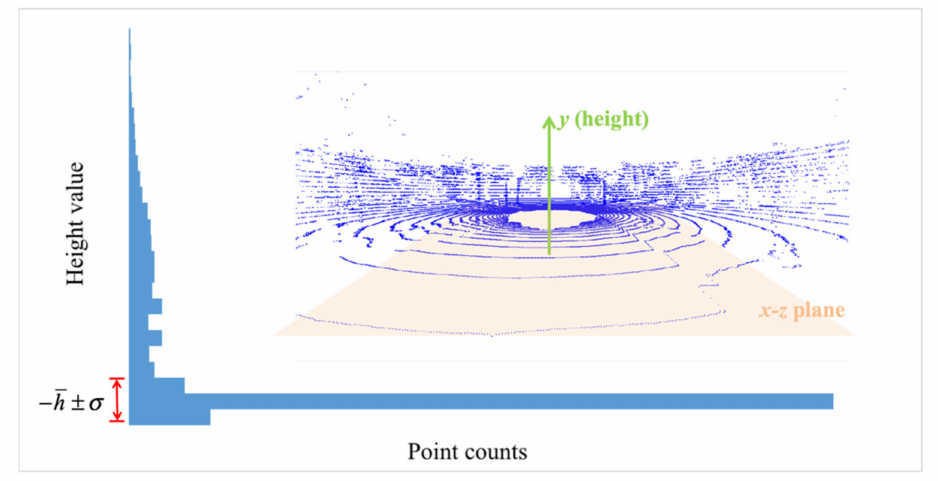
Figure 2. Height distribution of a frame of point